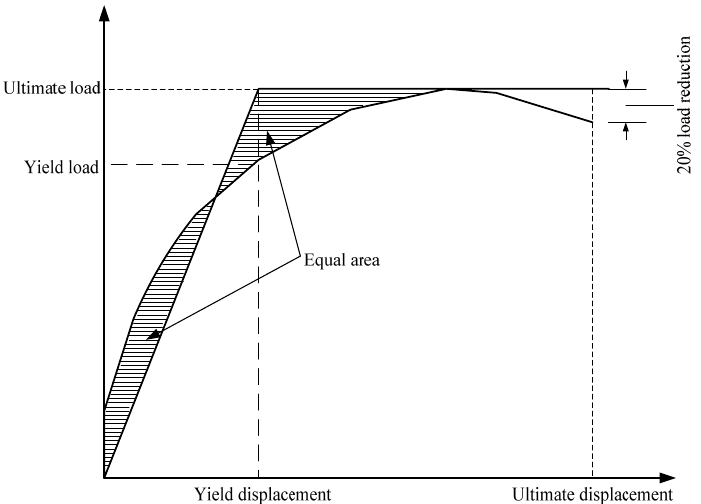
Figure 13. A schematic diagram of the equal area method. Table 3. The carrying capacity of the joints.